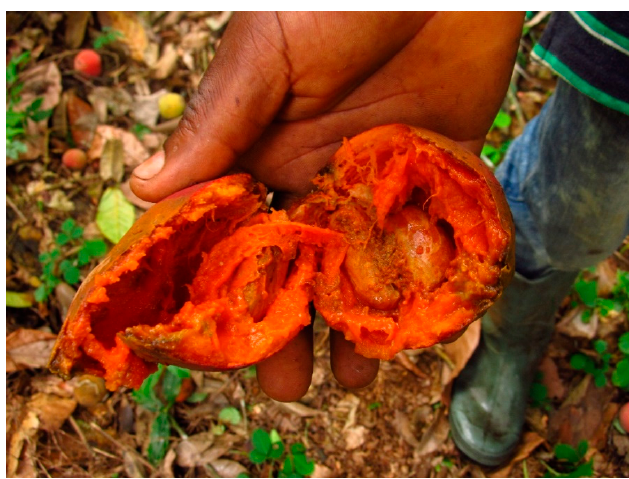
Figure 4. Ripening stages of G. kola fruits, from immature (green) to overripe (brownish). Source: author’s archive.